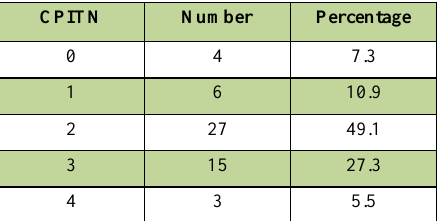
Table 1. The CPITN status of the subjects studied.